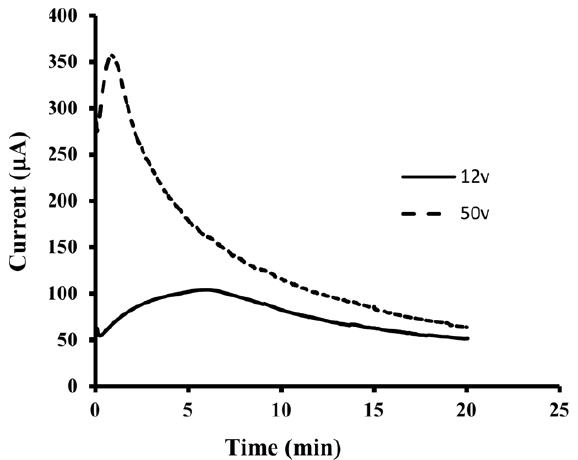
Figure 5. The system current, as a function of extraction time, obtained with EME at an applied voltage of 50 V and 12 V.